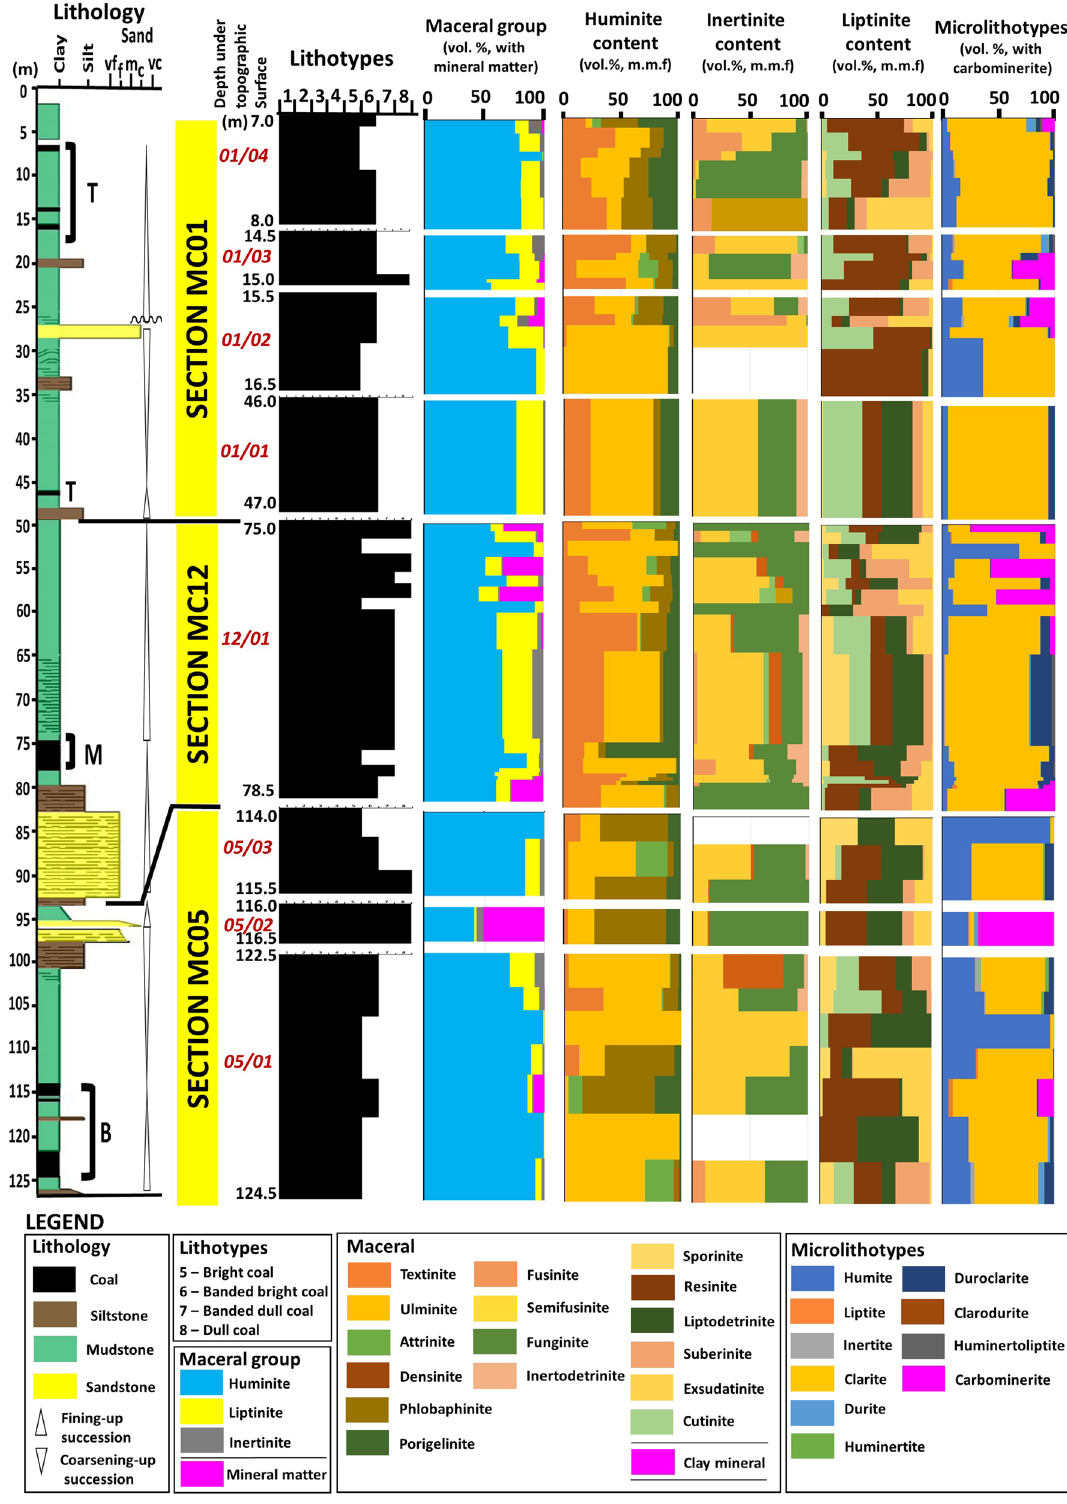
Figure 2. Complete vertical profile of the eight coal seams from Mukah coalfield showsupward compositional changes in lithotypes, maceral groups, macerals, mineral matter, and microlithotypes. Note coal seam is labeled as